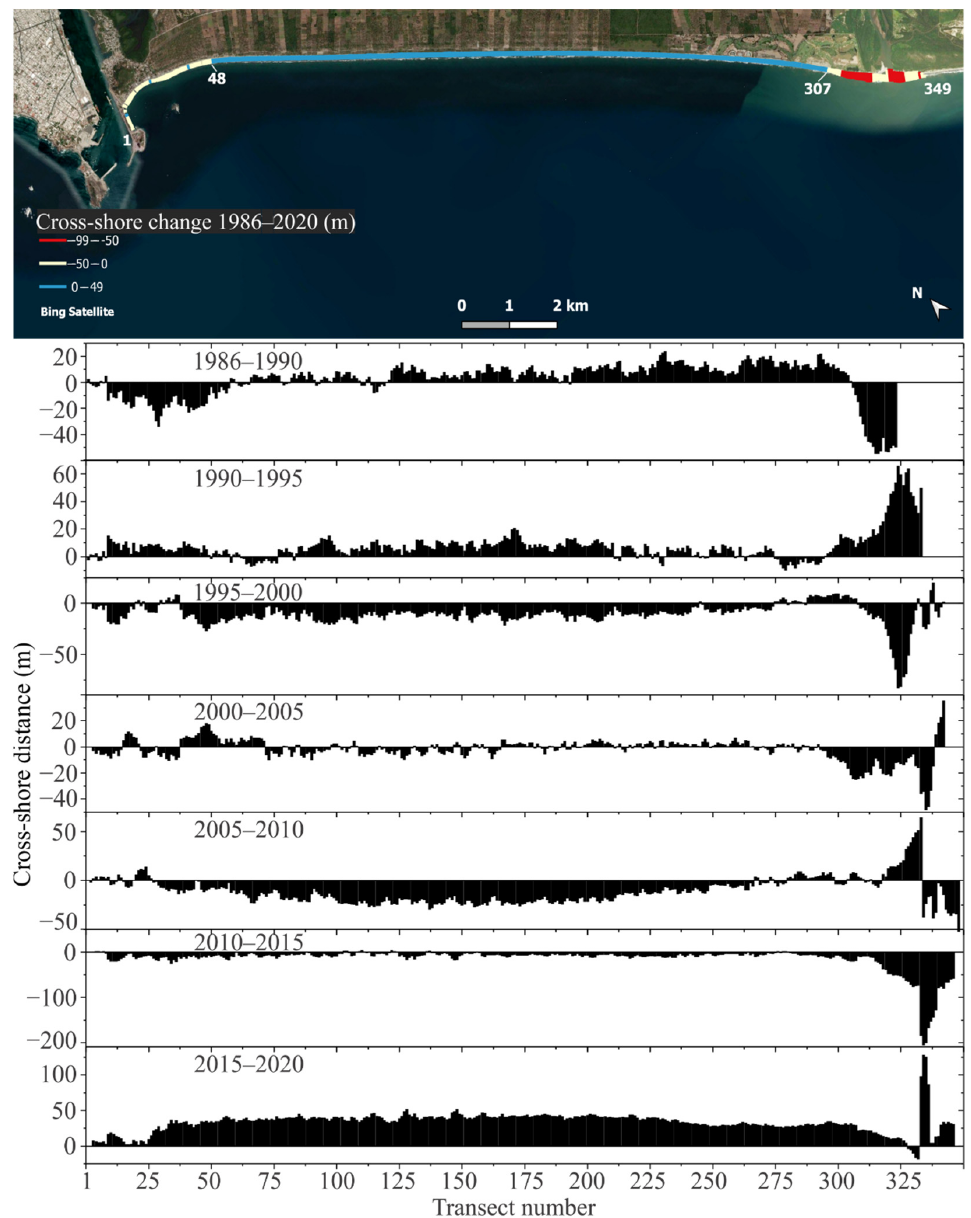
Figure 6. Across-shore distance change (1986–2020) along the coastline’s southern section of the study site ( top ). Specific accretion and erosion sections among the seven periods, based on the CoastSat and DSAS analyses ( bottom ). Positive values represent accretion, while negative values indicate erosion.